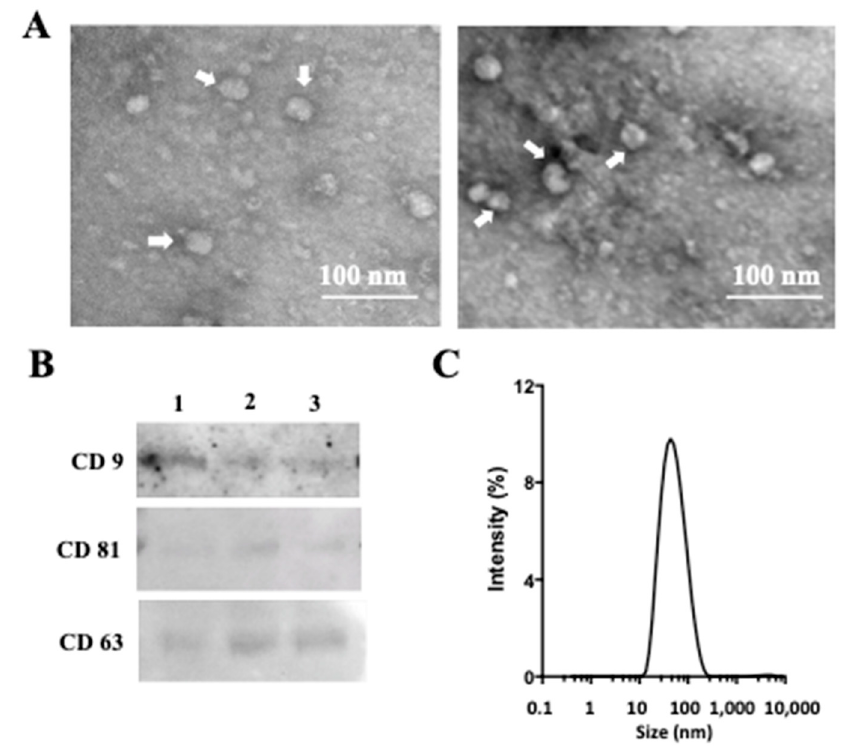
Figure 6. Characterization of exosomes isolated from AM-stromal cells. Exosomes were isolated from conditioned media prepared from AM-stromal cells. Exosomes were examined by transmission electron microscopy ( A ). Representative exosomes are indicated by white arrows. Scale bar = 100 nm. The presence of tetraspanins in exosomes was determined by SDS-PAGE followed by Western blot using antibodies against human CD9, CD63, and CD81 ( B ). Samples in Lane 1–3 were from different isolation batches. The particle sizes of exosomes were analyzed using dynamic light scattering. The size distributions were graphed against the percentage of intensity ( C ).